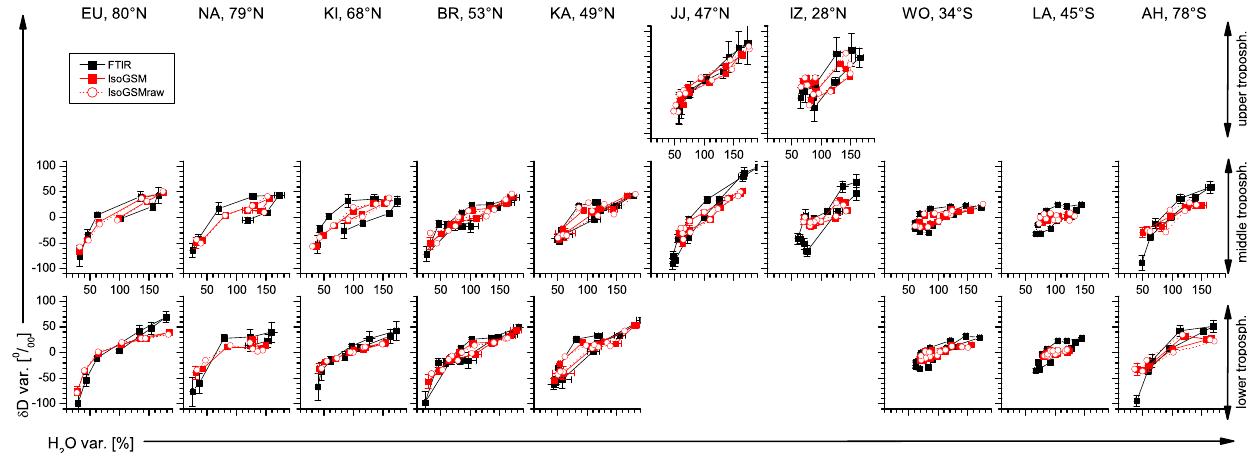
Fig. 16. Same as right graph of panel (b) of Fig. 15, but for lower, middle, and upper troposphere of all ten sites contributing to MUSICA.